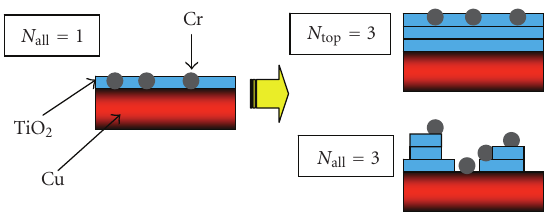
Figure 9: Di ff erence of coating structure of Cr-doped TiO 2 film between N all and N top